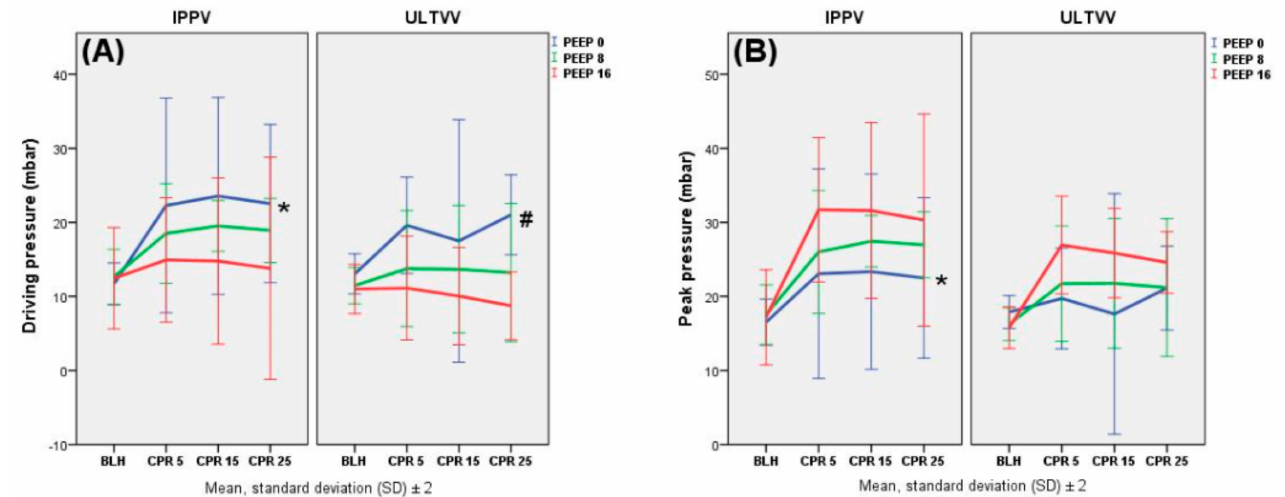
Figure 1. Ventilation: driving pressure (P drive , ( A )), peak pressure (P peak , ( B )). Airway pressures were measured in mbar. Data are shown as mean values and standard deviation (SD). Significant differences in P drive ( A ): * vs. I16, p = 0.010; # vs. U16, p = 0.003 (Tukey). Significant differences in P peak ( B ) * vs. I16, p = 0.011